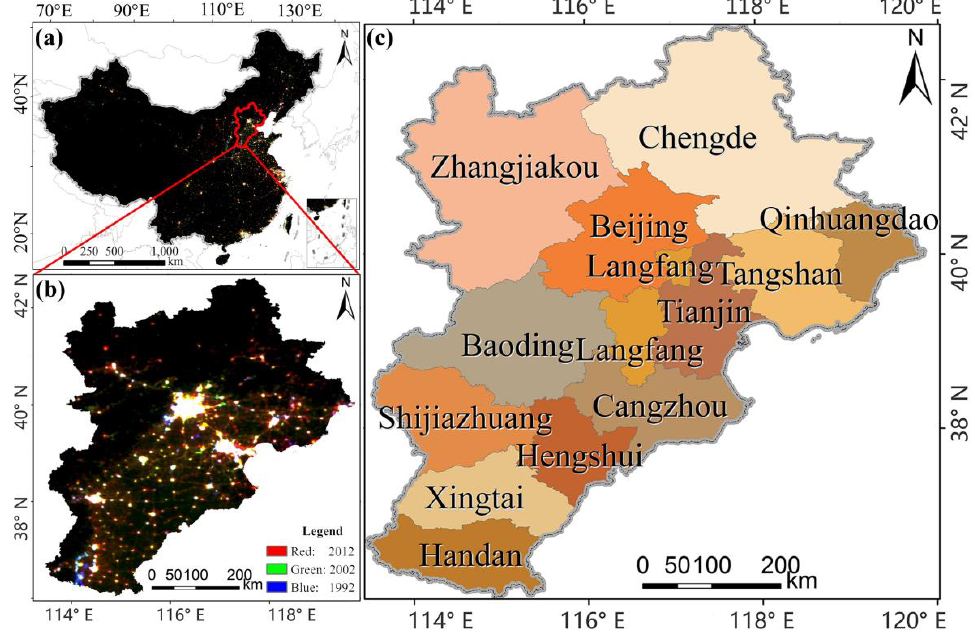
Figure 1. Study area (colour composite of nighttime lights of 1992 (blue), 2002 (green), 2012 (red)): ( a ) colour composite of China; ( b ) colour composite of the study area, the Beijing-Tianjin-Hebei region; ( c ) administrative division map of the study area.